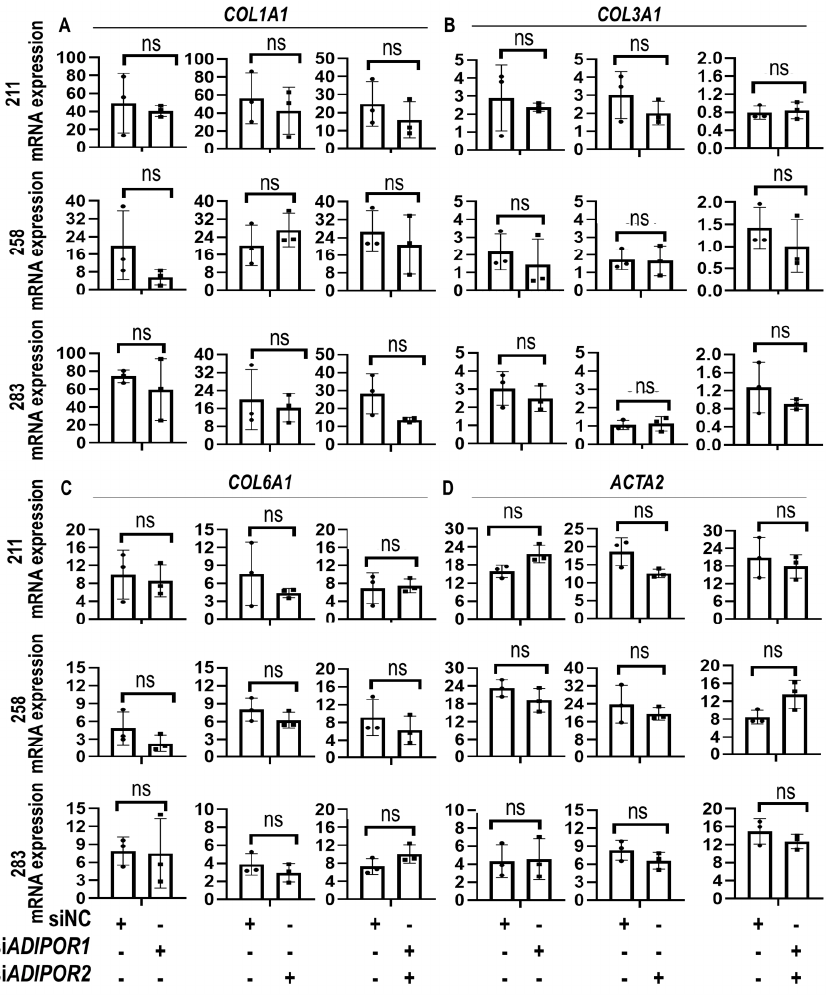
Figure 5. Depletion of ADIPOQ receptors preserves expression of fibrosis-related markers. Gene expression data obtained by RT-qPCR for fibrosis-related genes COL1A1 ( A ), COL3A1 ( B ), COL6A1 ( C ), and ACTA2 ( D ) after transfection with non-silencing control (siNC), or siRNAs for ADIPOR1 (si ADIPOR1 ), ADIPOR2 (si ADIPOR2 ) or the combination of ADIPOR1 and ADIPOR2 (si ADIPOR1 + si ADIPOR2 ) in MSCs derived from three distinct donors (211, 258 and 283). Statistical difference in gene expression between groups is shown with brackets. Asterisks indicate differences in probability values: p > 0.05 = not significant (ns). Statistical significance and error bars (mean ± standard deviation) are based on n = 3 biological replicates for each of the three MSC donors (data points superimposed on the graphs).